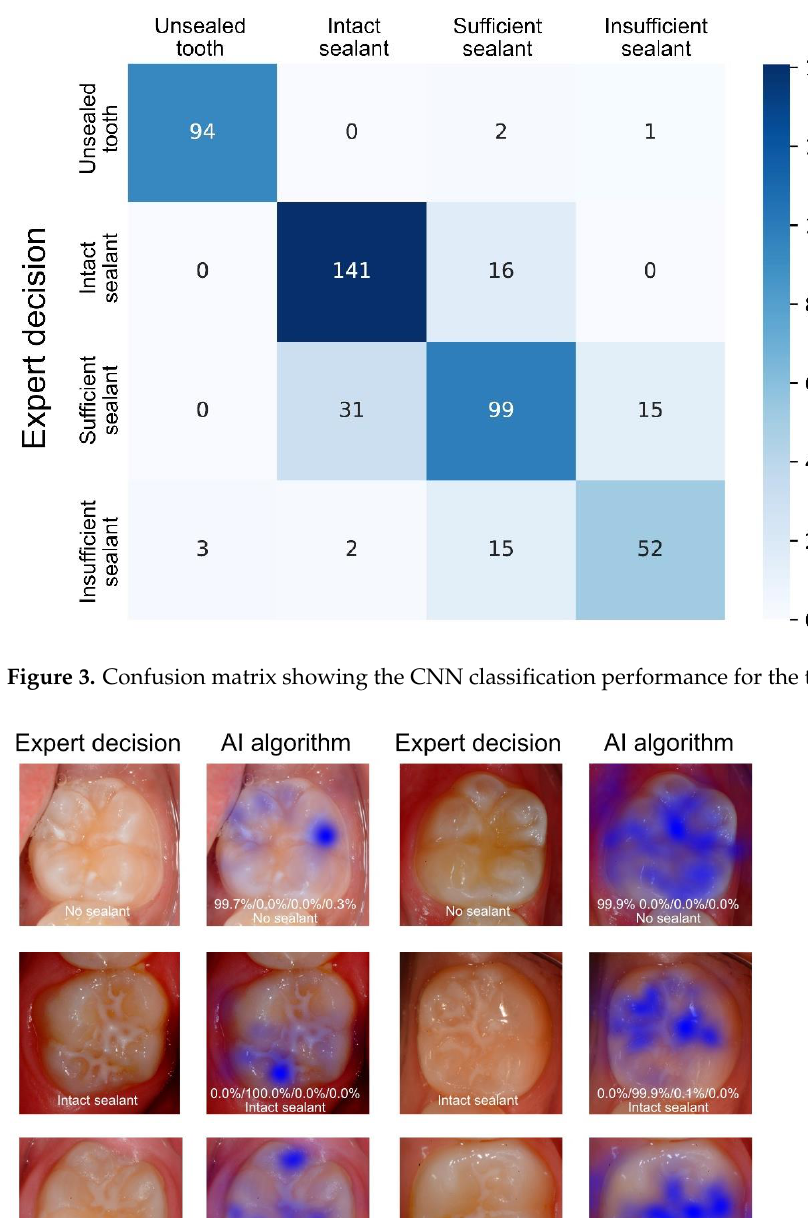
Figure 2. The ROC curves illustrate the model performance of the developed CNN for overall and categorical sealant detection.